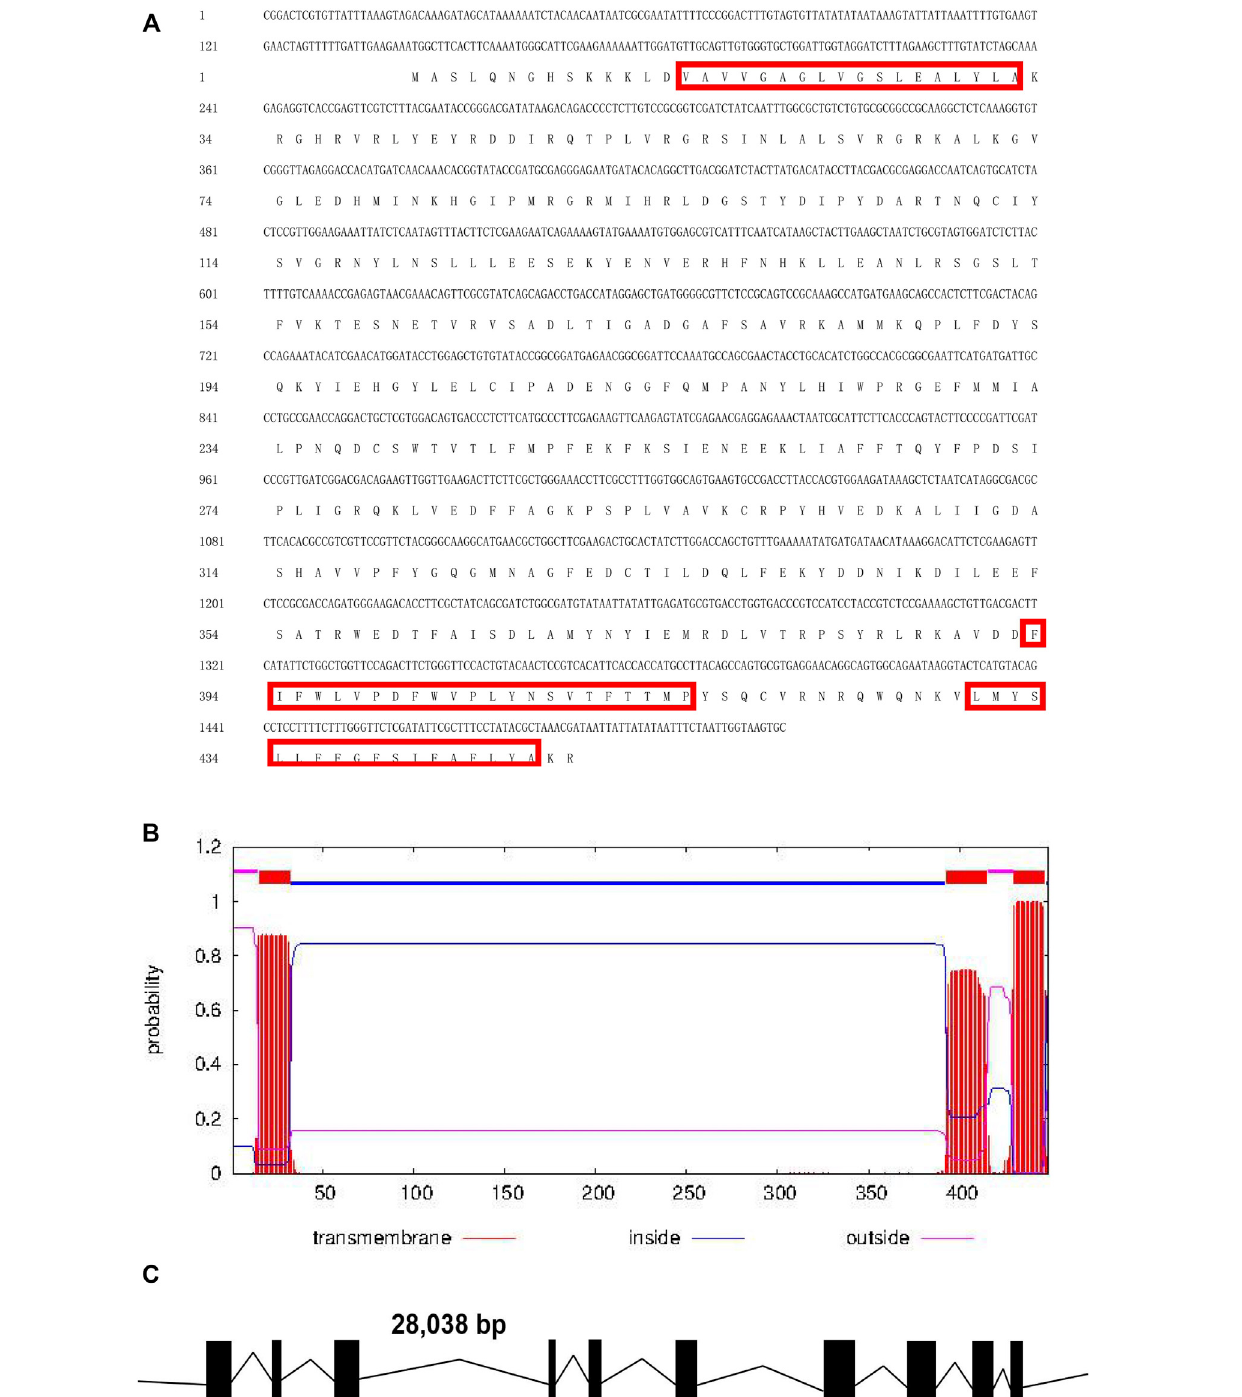
Frontiers in Genetics |